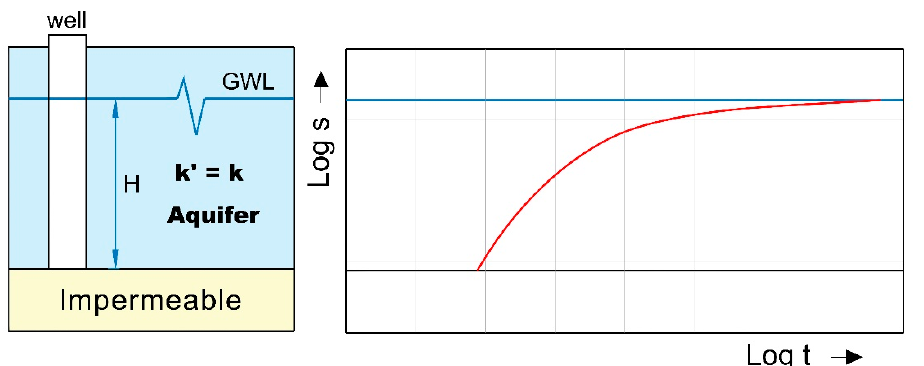
Figure 3. Time-drawdown curve in an unconfined aquifer.